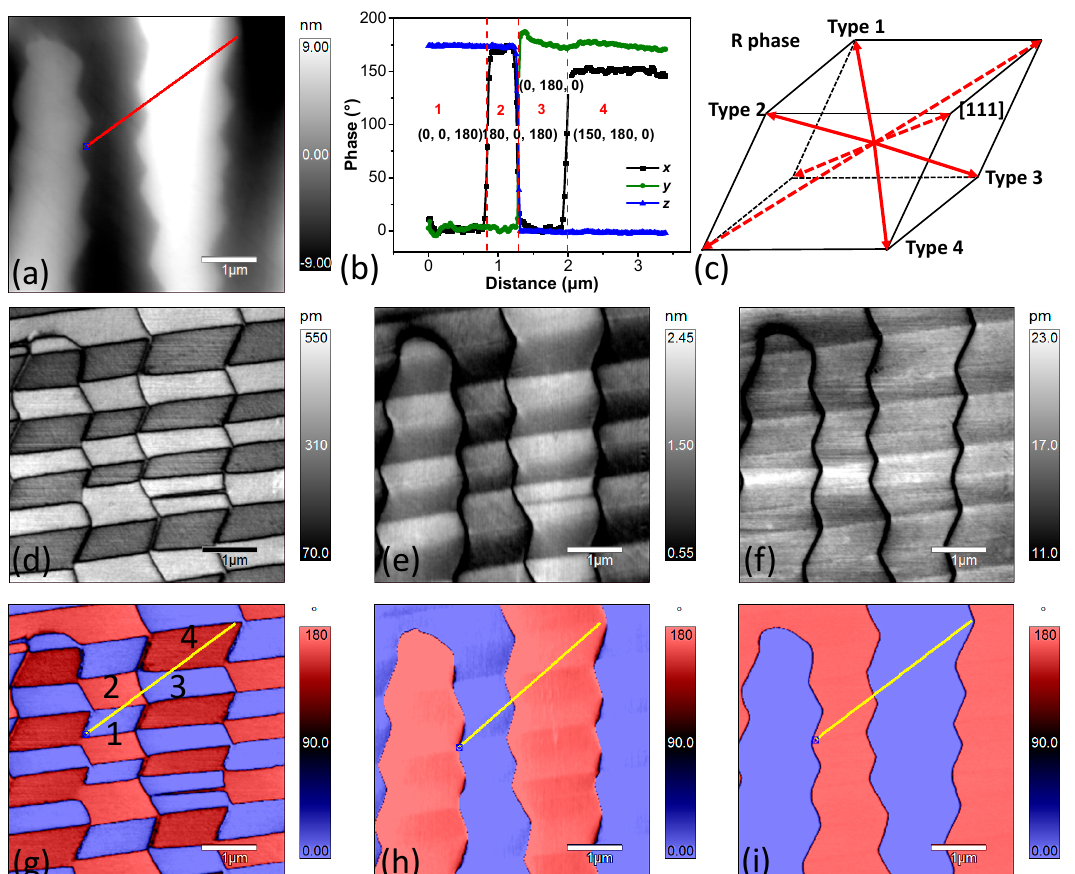
Figure 2. Topography and piezoresponse force microscopy (PFM) images of the PZN-7%PT single crystal at room temperature: ( a ) topography; ( d – f ) amplitude images of length (x-LPFM), width (y-LPFM), and thickness (VPFM), respectively; and ( g – i ) phase images of x-LPFM, y-LPFM, and VPFM, respectively. ( b ) extracted profiles of the phase data along the lines indicated in ( g – i ); and ( c ) possible polarization orientations in the rhombohedral phase.